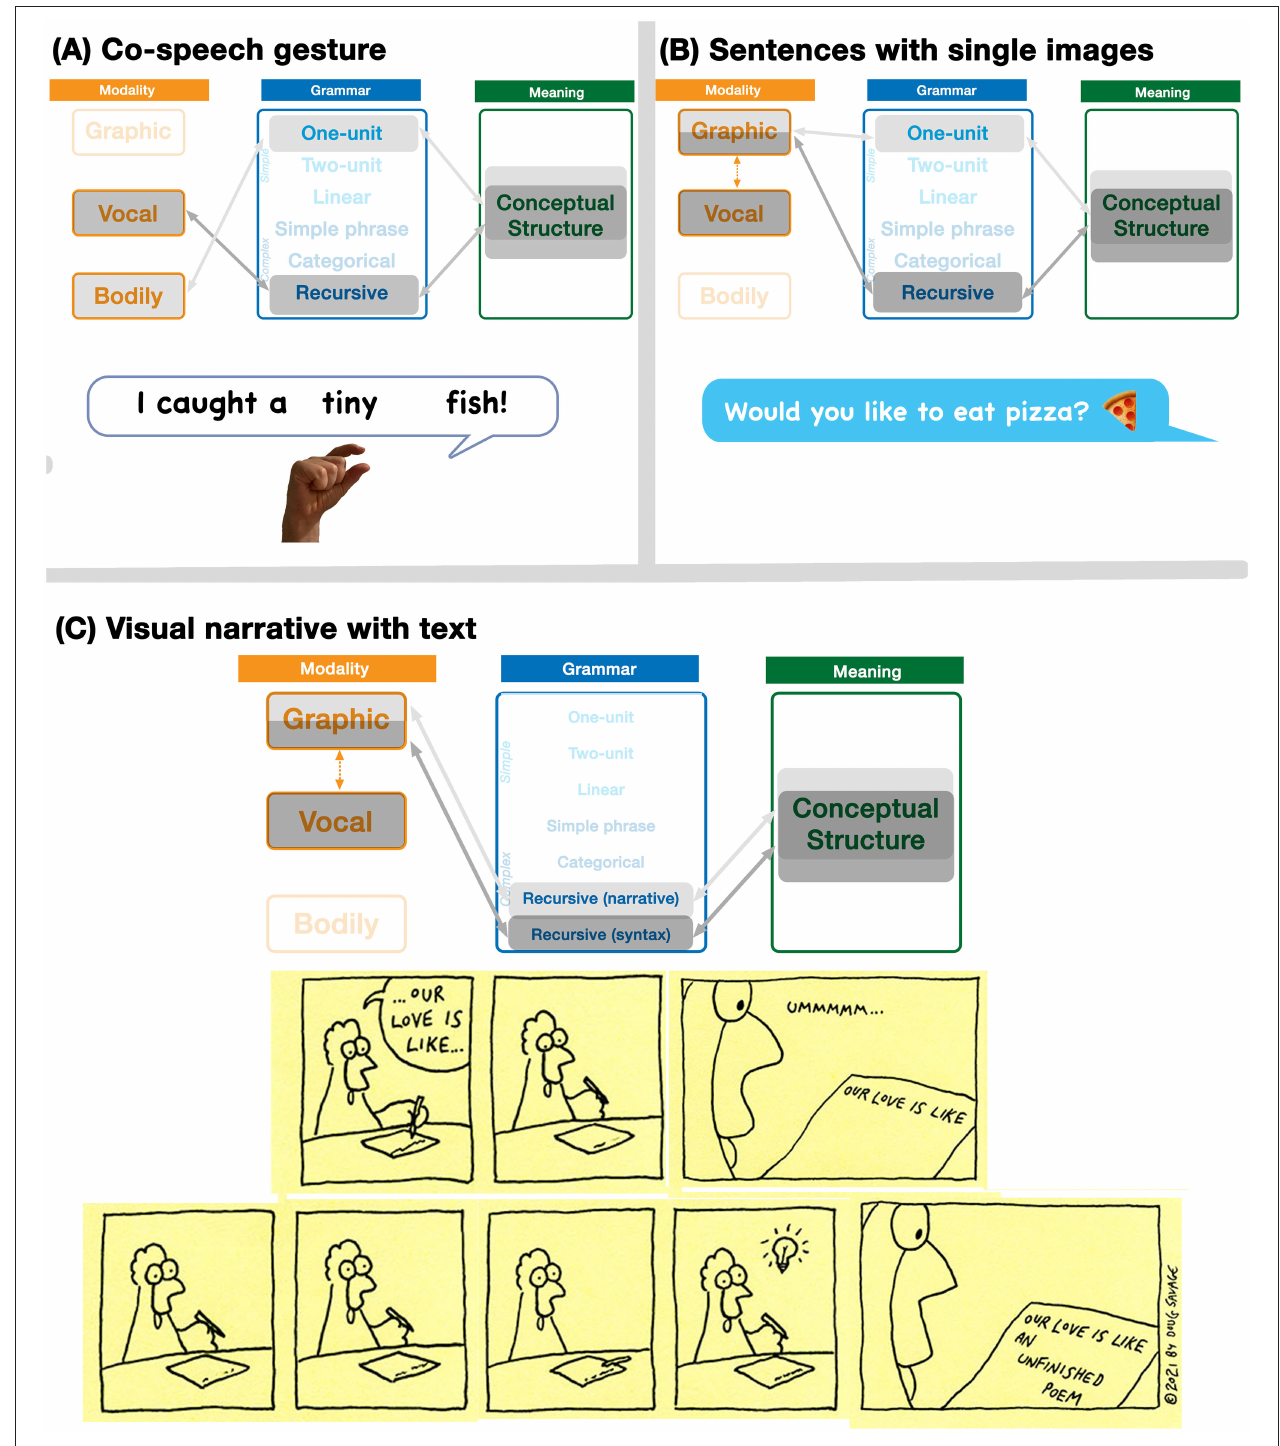
FIGURE 4 | Multimodal interactions arising in the Parallel Architecture. Emergent states here describe (A) co-speech gesture, (B) text-emoji relationships, and (C) a visual sequence using a narrative grammar alongside grammatical text. Savage Chickens is © 2021 Doug Savage.